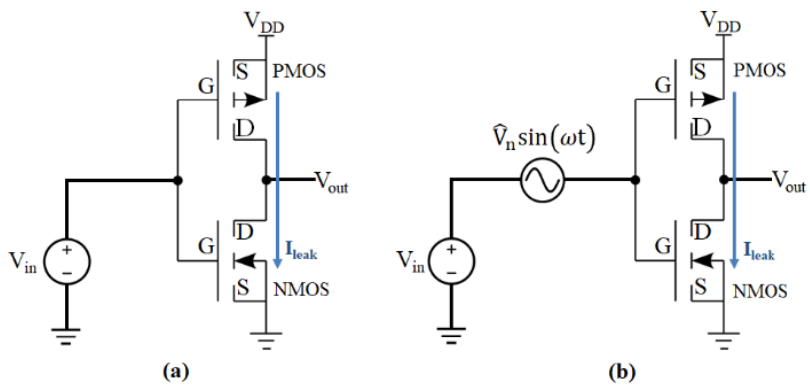
Figure 1. Leakage current of a CMOS inverter in standby mode ( a ) with ( b ) without RF injection